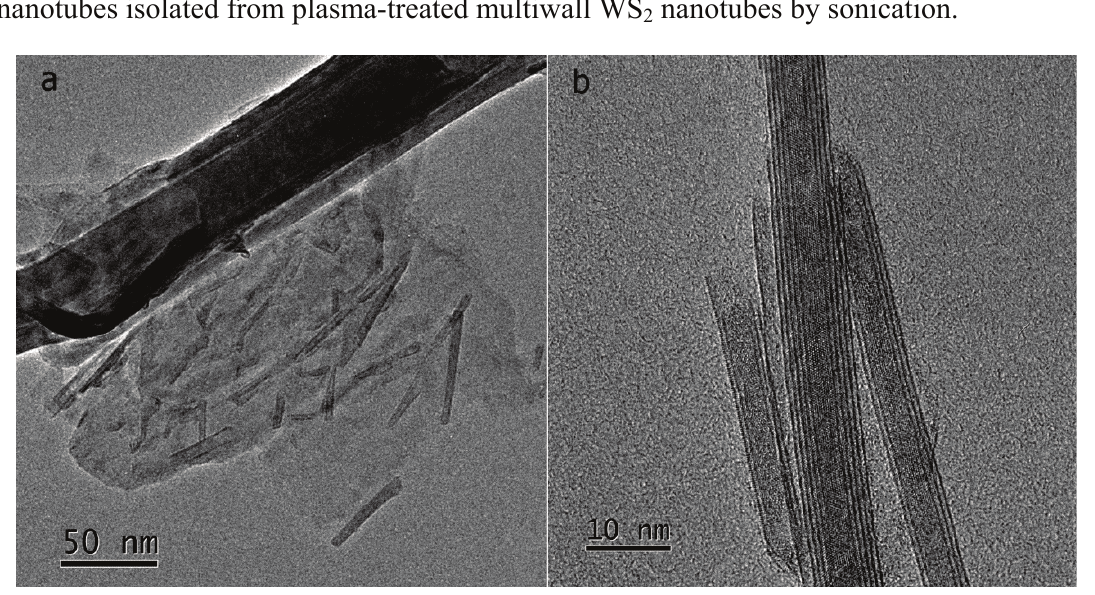
Figure 3. TEM images of daughter WS multiwall inorganic nanotube (INT)-WS daughter nanotubes next to a treated multiwall nanotube; ( b ) A group of daughter nanotubes isolated from plasma-treated multiwall WS